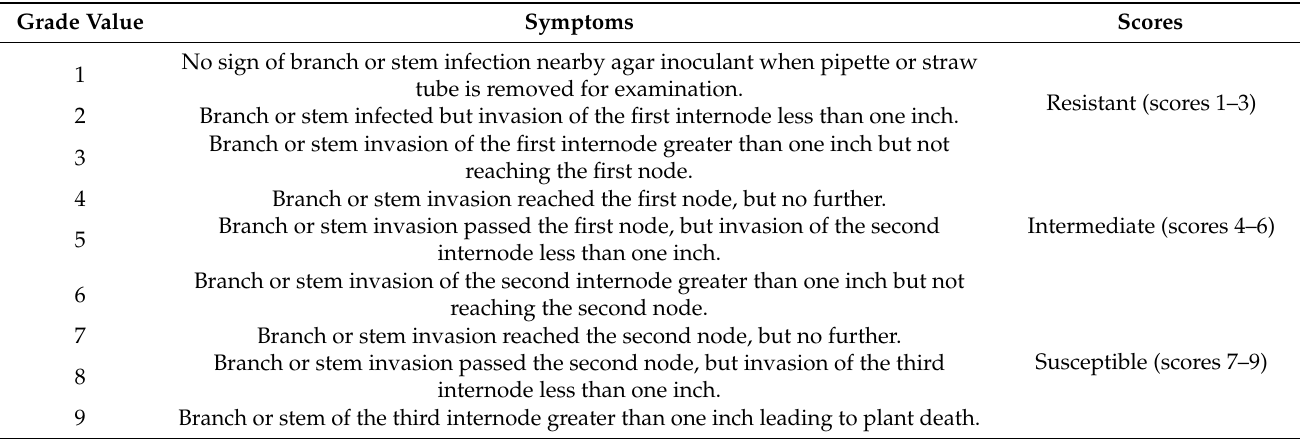
Table 1. The pathogenicity assessment of green mold pathogen against beans plant using resistance scale of Teran et al.,